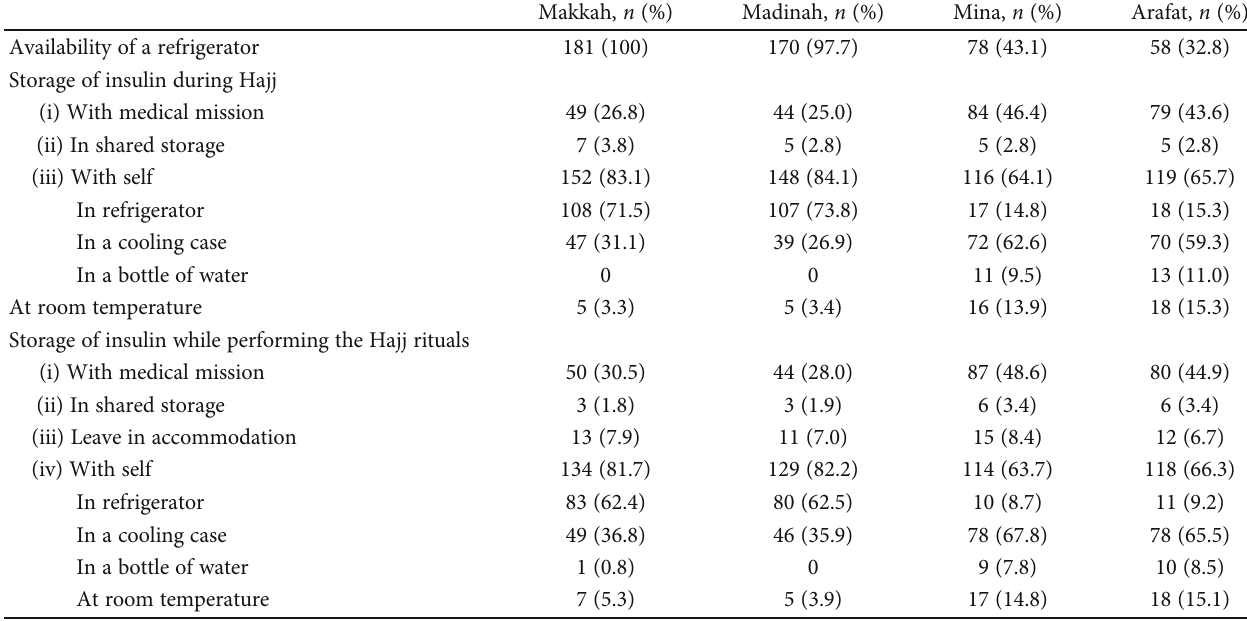
Table 4: Insulin handling and storage during the